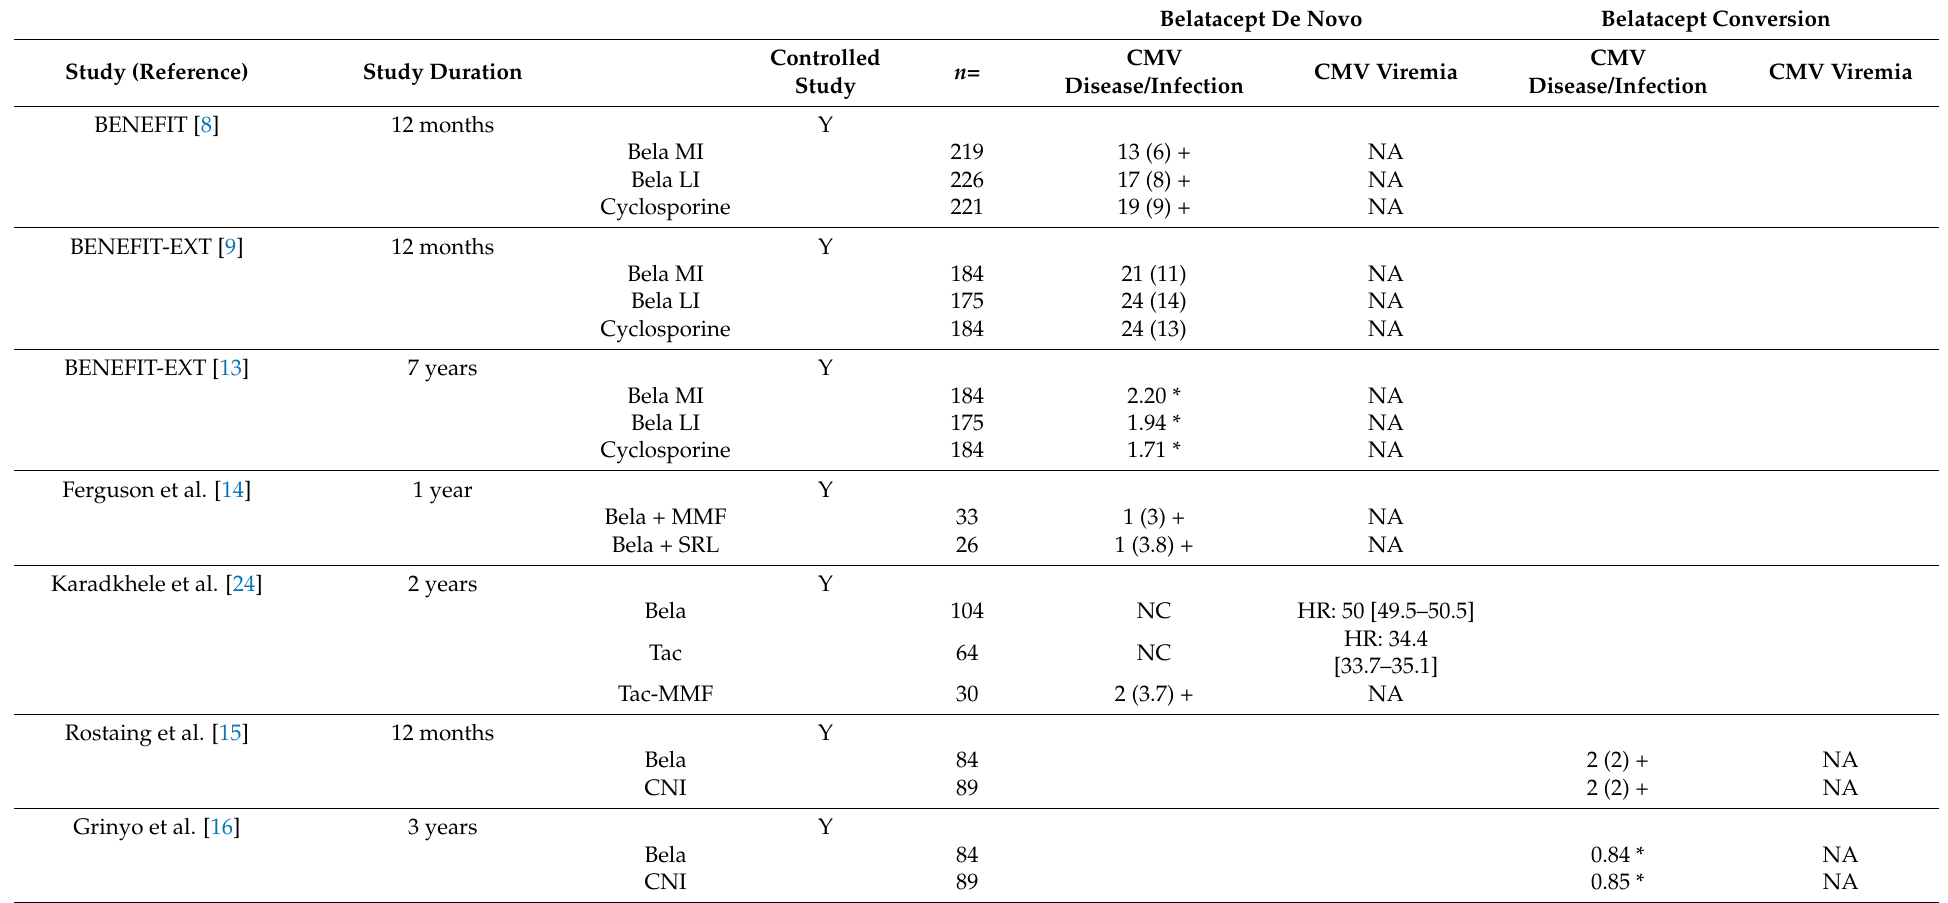
Table 1. Incidence of CMV